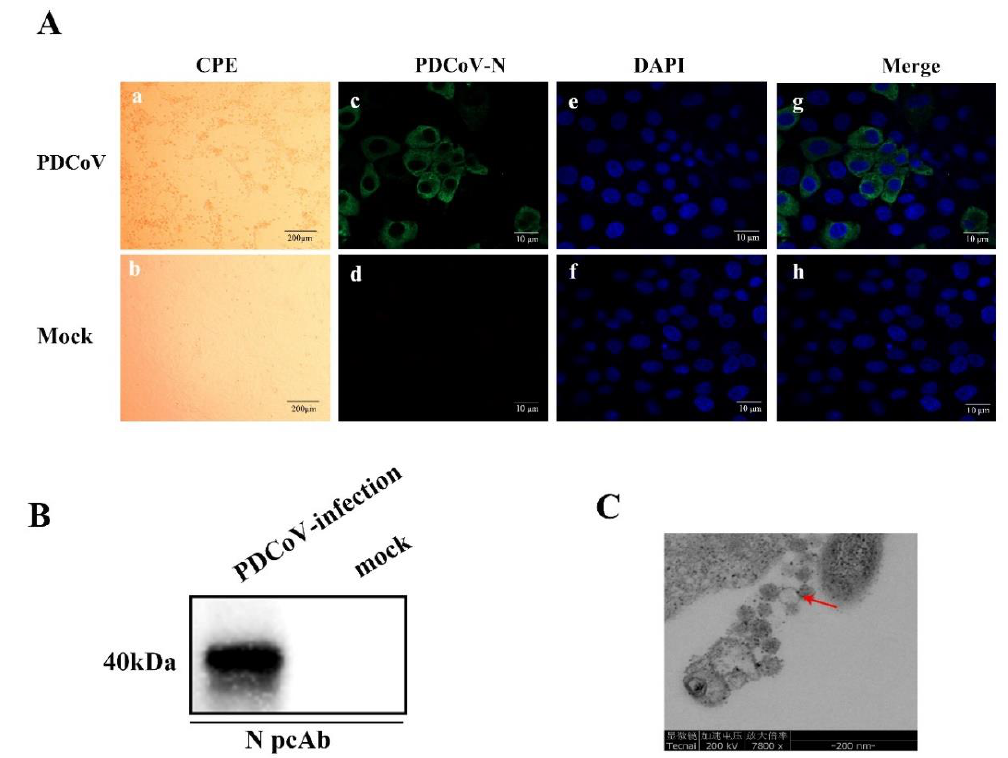
Figure 1. Isolation and characterization of porcine deltacoronavirus (PDCoV) strain CHN-JS-2017. ( A ) The cytopathic effect (CPE) and immunofluorescence staining (IFA) of LLC-PK cells infected with PDCoV. ( a ) CPE of LLC-PK cells at 24 h after PDCoV infection. ( b ) Morphology of the mock-treated LLC-PK cells at 24 h. ( c – h ) PDCoV-infected or mock-treated LLC-PK cells were examined by IFA at 24 hpi using polyclonal against PDCoV N protein. ( c and d ) IFA with PDCoV N protein (green), ( e and f ) IFA with 4′,6-diamidino-2-phenylindole (DAPI)(blue), all views were visualized by using a fluorescence microscope. ( B ) PDCoV-infected or mock-treated LLC-PK cells were subjected to analysis with polyclonal antibodies against PDCoV N protein by Western blot at 24 hpi. ( C ) Electron microscopic image of PDCoV particles. The red arrow points to the virus particle.